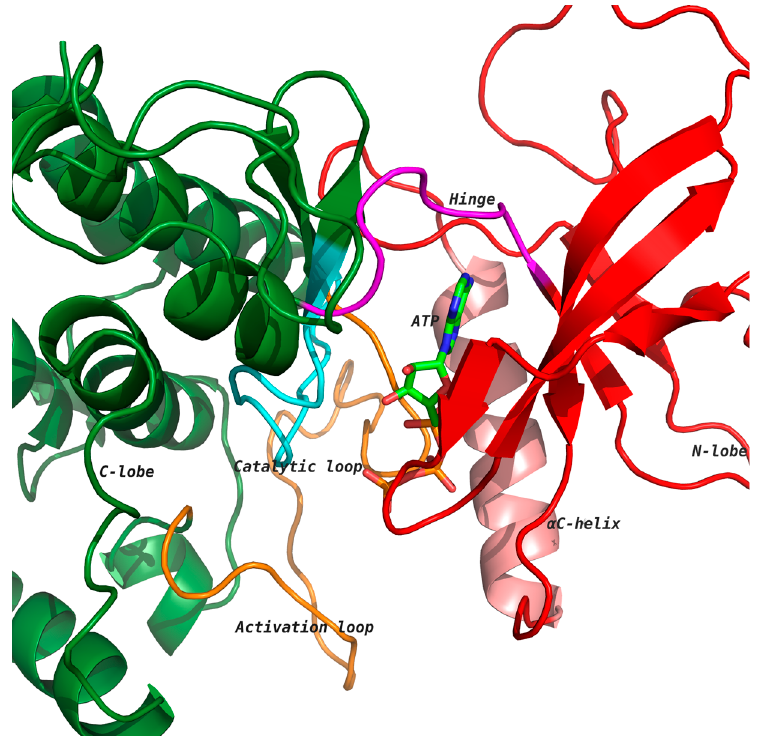
Figure 1. General structure of a kinase domain consisting of two lobes, a helix-rich C-terminal lobe (green) and a sheet-rich N-terminal lobe (red). The ATP binding pocket is present at the interface of the two lobes. The heterocyclic ring of ATP forms hydrogen bonds with the hinge loop (magenta). The activation loop (orange) undergoes a conformation change upon phosphorylation of a conserved residue allowing the substrate to bind. Arginine of the His-Arg-Asp (HRD) motif in the catalytic loop interacts with phosphate in the activation segment. Aspartate of the HRD motif accepts a proton from the substrate hydroxyl group during phosphotransfer mechanism.